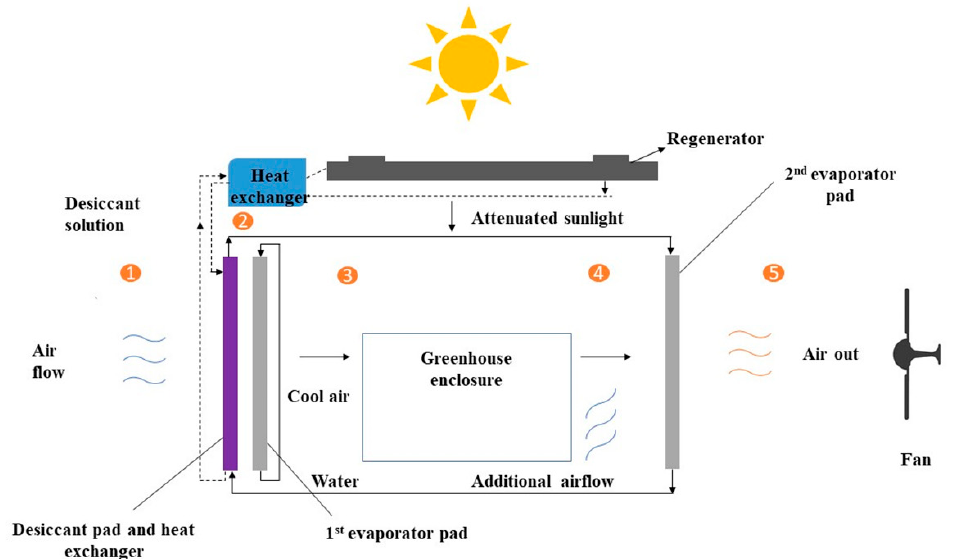
Figure 5. Schematic representation of a solar assisted liquid desiccant system with evaporative pad cooling for greenhouse crops (Modified from Davies [176]). 557